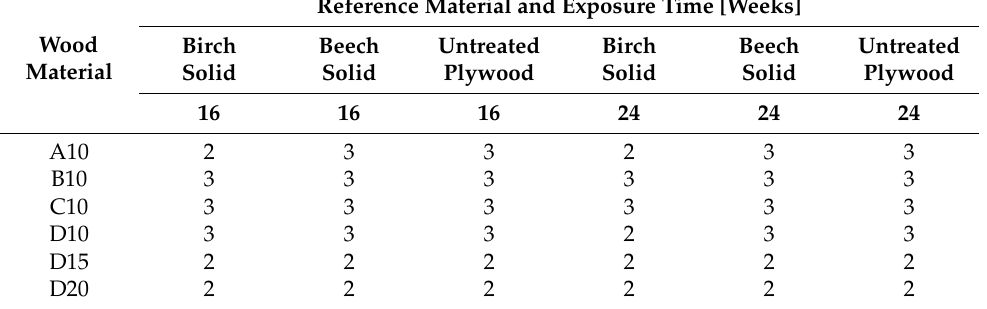
Table 6. Durability class ratings according to CEN/TS 15083-2:2005 [28] after 16 and 24 weeks of incubation in unsterile